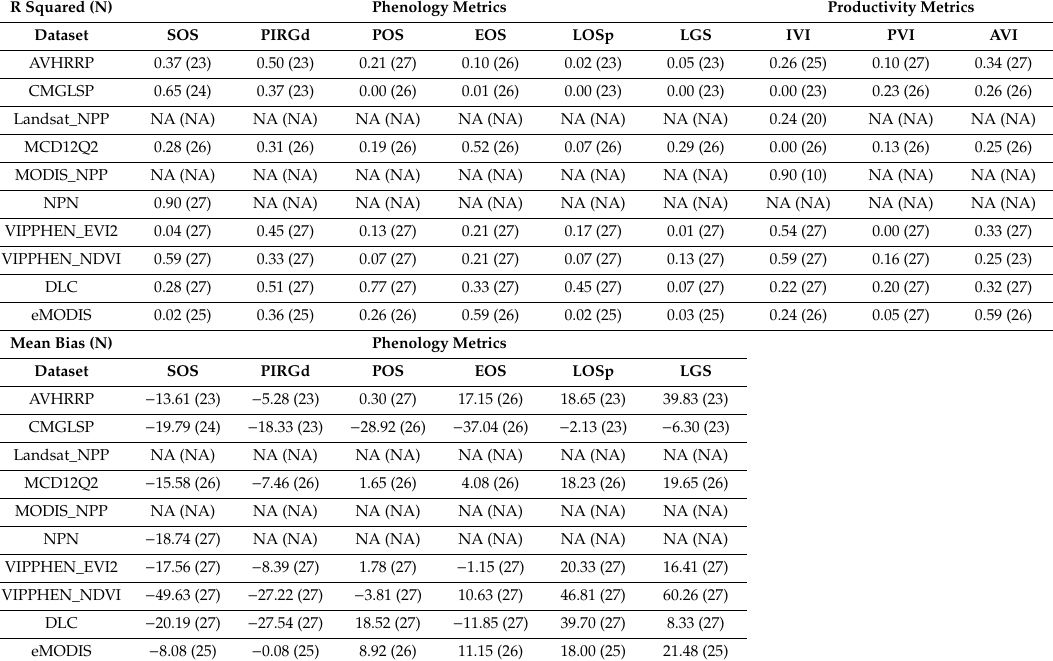
Table A5. Deciduous / Broadleaf (DB) results.